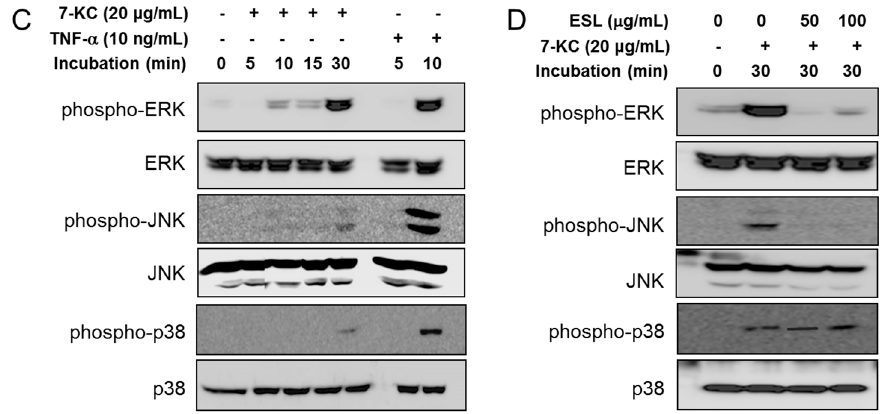
Figure 3. Effects of ESL on the expression of KLF2 and VCAM-1 proteins and atherogenic genes, and phosphorylation of mitogen-activated protein kinases (MAPKs) in 7-ketocholesterol (7-KC)-stimulated HUVECs. ( A ) The cells were pretreated with or without ESL for 2 h, and then stimulated with 7-KC in a dose- and time-dependent manner; ( B ) The mRNA levels of the indicated targets were determined by real-time qRT-PCR as described in the Materials and Methods Section. # p < 0.01 vs. untreated group. * p < 0.05 and ** p < 0.01 vs. the 7-KC-treated group; ( C ) The cells were stimulated with 7-KC or TNF- α for the indicated incubation times; ( D ) Cells were pretreated with or without ESL for 2 h, and then stimulated with 20 µg/mL 7-KC for 30 min. The protein levels were analyzed by Western blot with the respective primary antibodies and the corresponding phospho-specific antibodies. The total MAPK level was used as the internal control.